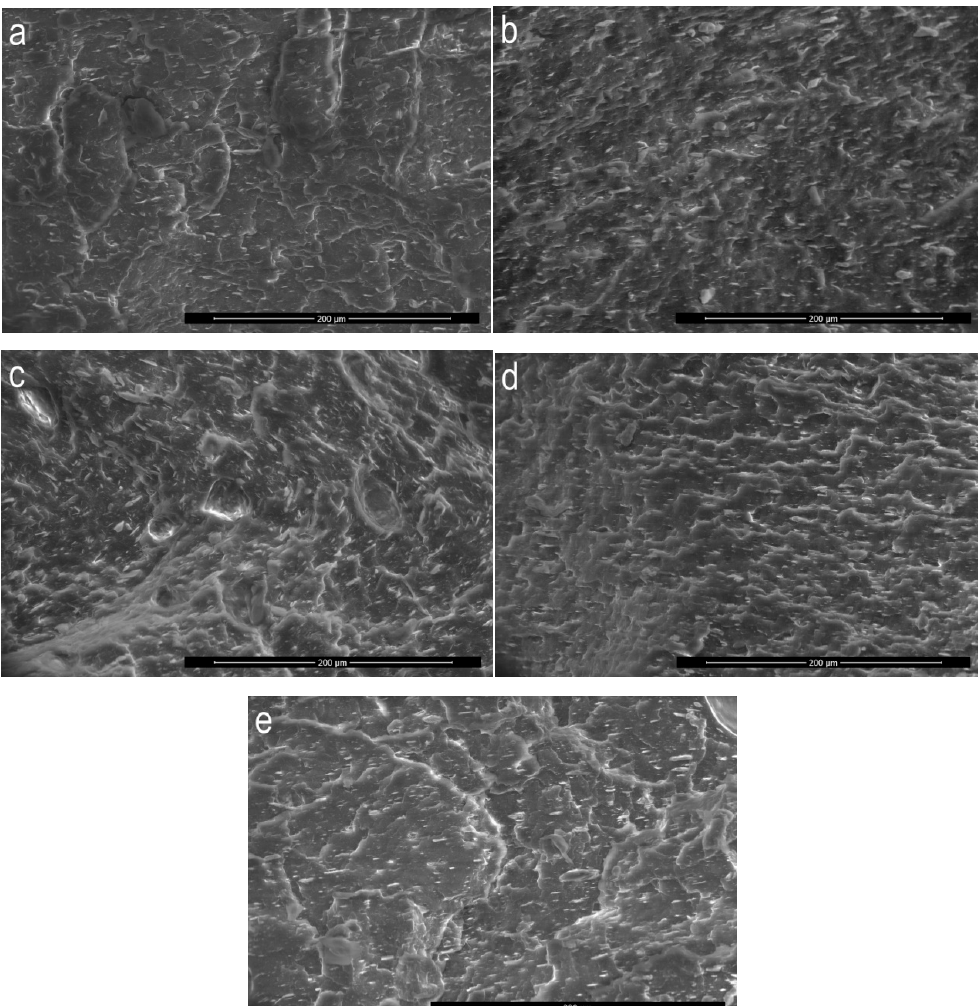
Figure 13. SEM images of microstructure for selected experimental design layouts: layout 13-( a ); layout 14-( b ); layout 12-( c ); layout 10-( d ); layout 6-( e ).